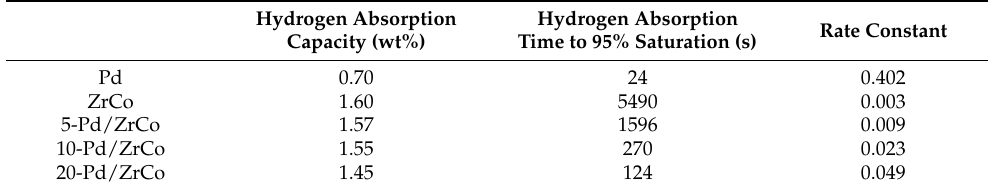
Figure 2. Surface and cross-sectional SEM pictures at a magnification of 10,000×: ( a , b ) Pd; ( c , d ) ZrCo; ( e , f ) 5-Pd/ZrCo; ( g , h )10-Pd/ZrCo; ( i , j ) 20-Pd/ZrCo films. Table 2. The hydrogen absorption capacity, hydrogen absorption time to 95% saturation, and rate constant of the Pd, ZrCo, and Pd/ZrCo films.